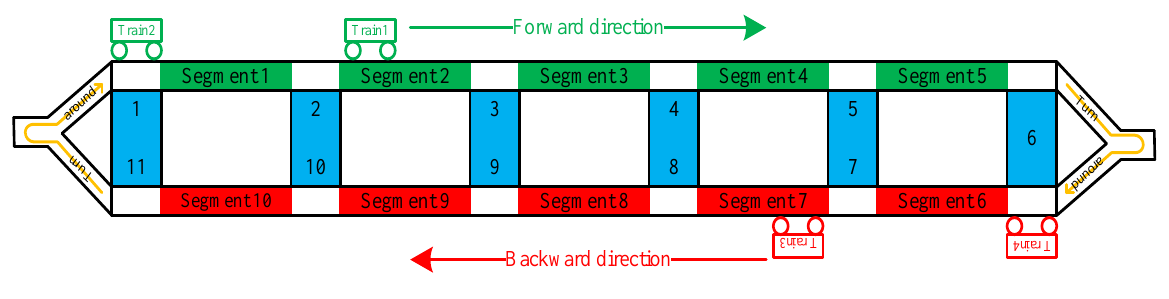
Figure 9. The schematic diagram of the pilot system.